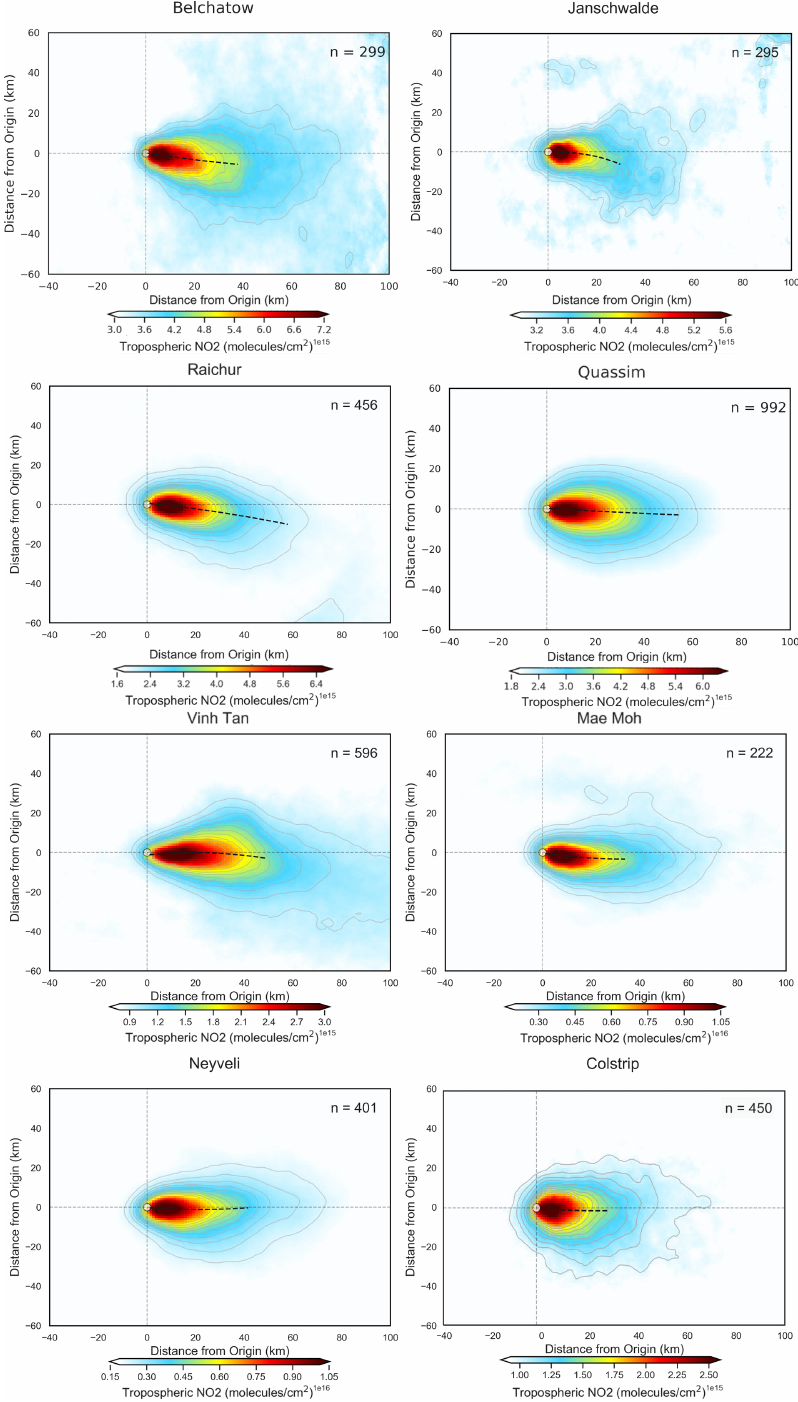
Figure A1. Wind-rotated aggregates of all Northern Hemisphere sites, with the plume spine signified by the dashed black line.